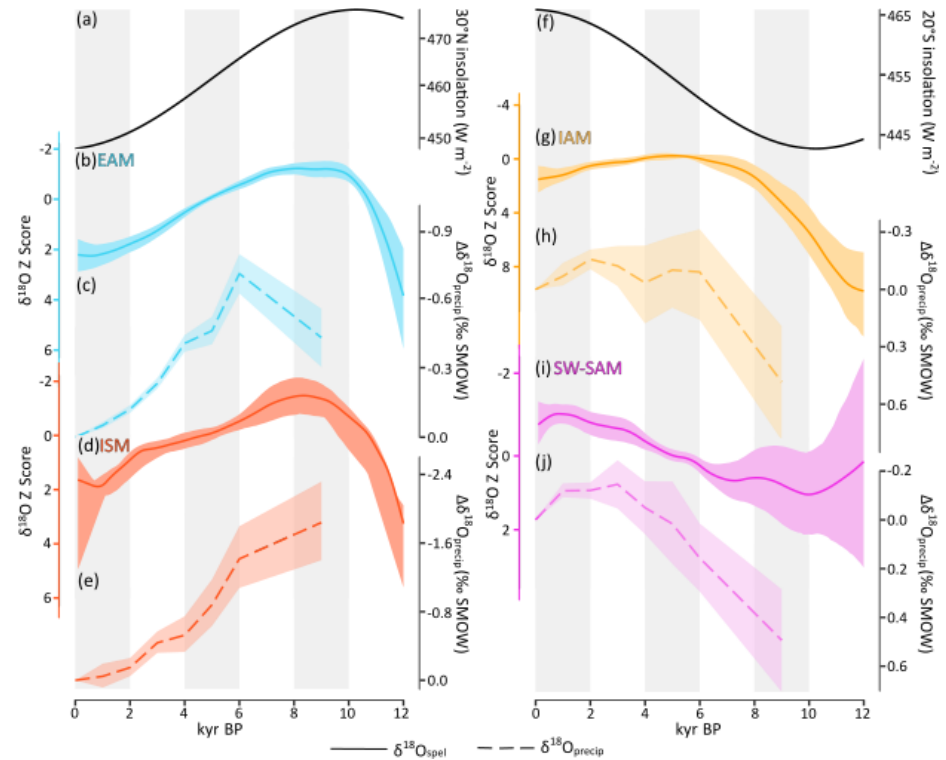
Figure 4. Evolution of regional speleothem δ 18 O signals through the Holocene compared to δ 18 O precip simulated by the GISS model. Panels (a–e) show Northern Hemisphere monsoons (EAM denotes the East Asian monsoon; ISM denotes the Indian summer monsoon) and summer (May through September) insolation at 30 ◦ N (Berger, 1978). Panels (f–j) show Southern Hemisphere monsoons (SW-SAM denotes the southwestern South American monsoon; IAM denotes the Indonesian–Australian monsoon) and summer (November through March) insolation for 20 ◦ S (Berger, 1978). The speleothem δ 18 O changes are expressed as z scores, with a smoothed loess fit (3000-year window), and confidence intervals obtained by bootstrapping by site. δ 18 O precip values are expressed as anomalies from the pre-industrial control simulation. Note that the isotope axes are reversed, so that the most negative anomalies are at the top of the plot, to be consistent with the assumed relationship with the changes in insolation.